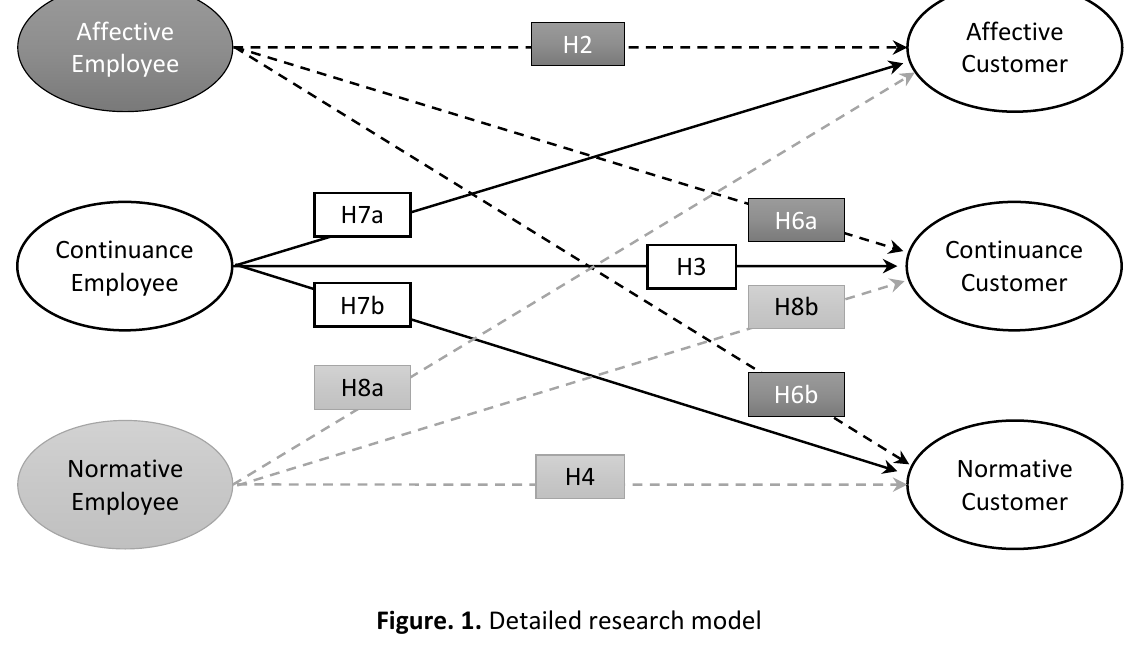
Figure. 1. Detailed research